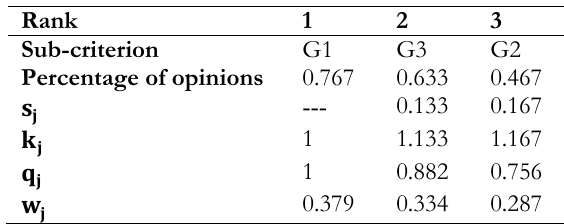
Table 14. Values of 𝐬 𝐣 , 𝐤 𝐣 , 𝐪 𝐣 and 𝐰 𝐣 .